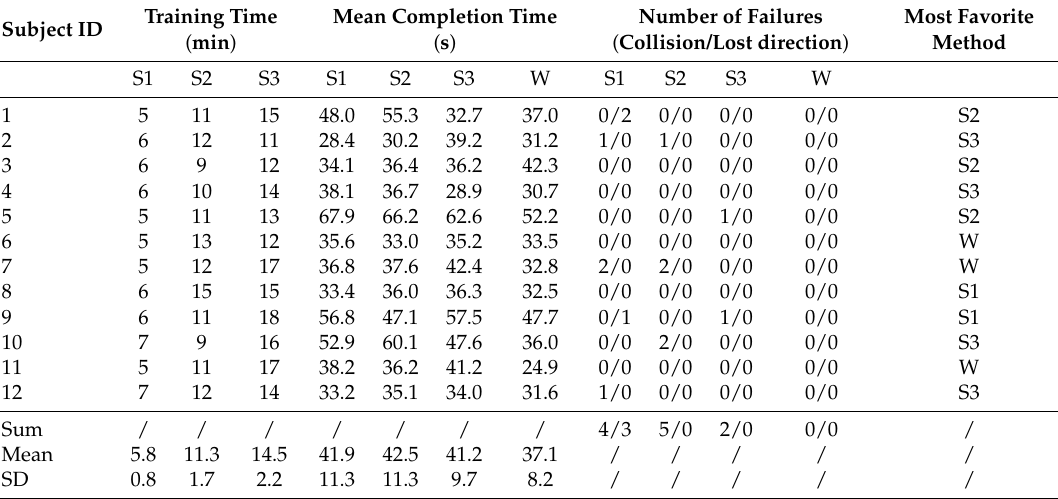
Table 5. Experiment results. S1, S2 and S3 represent image sonification, obstacle sonification and path sonification respectively, and W represents the white cane